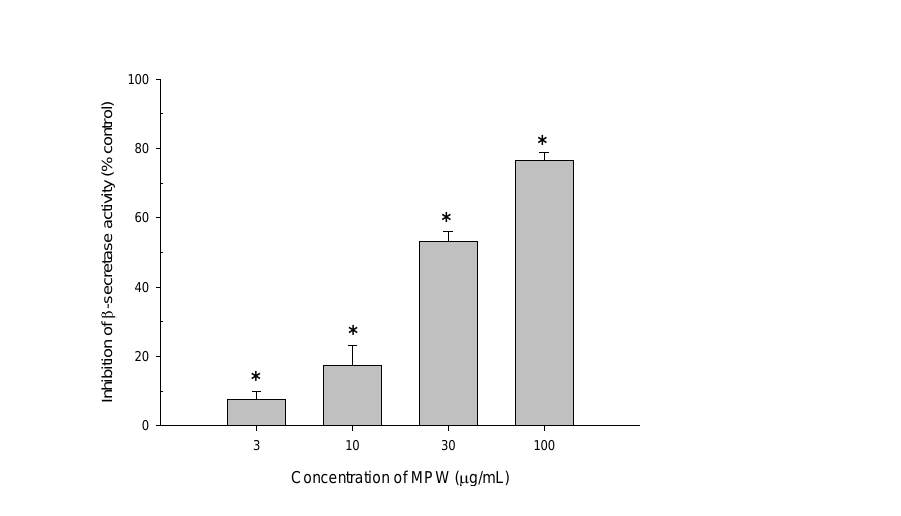
Figure 6. Effect of MPW on β-secretase activity. The β-secretase enzyme activities were determined using the in vitro β-secretase FRET assay in the absence or presence of MPW at various concentrations, as described in the Materials and Methods. The data are expressed as percentages of inhibition of the enzyme activity measured in the absence of MPW. Each data point represents the mean ± S.E.M. from at least three independent experiments conducted in duplicate (*, p < 0.05 vs. the enzyme activity measured in the absence of MPW).